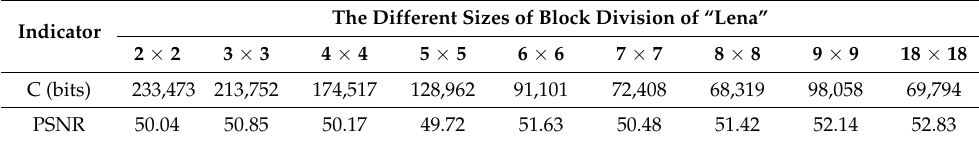
Table 2. Comparison of embedding capacity using different block sizes of Lena.